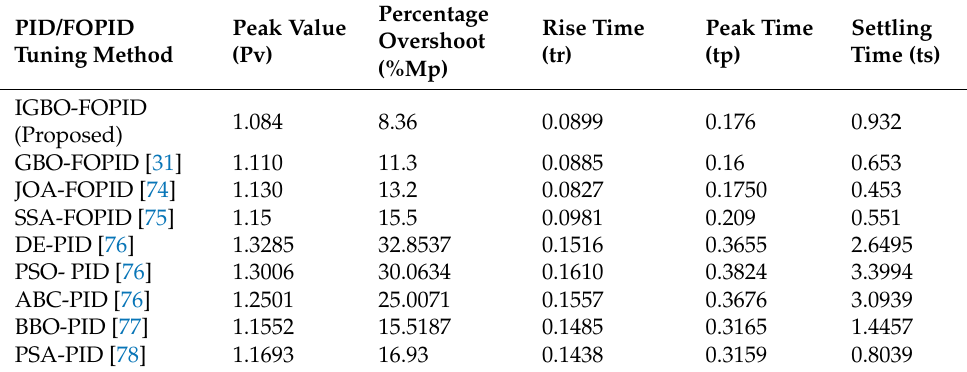
Table 14. Dynamic response evaluation of proposed GBO-based AVR design. PID/FOPID Tuning Method